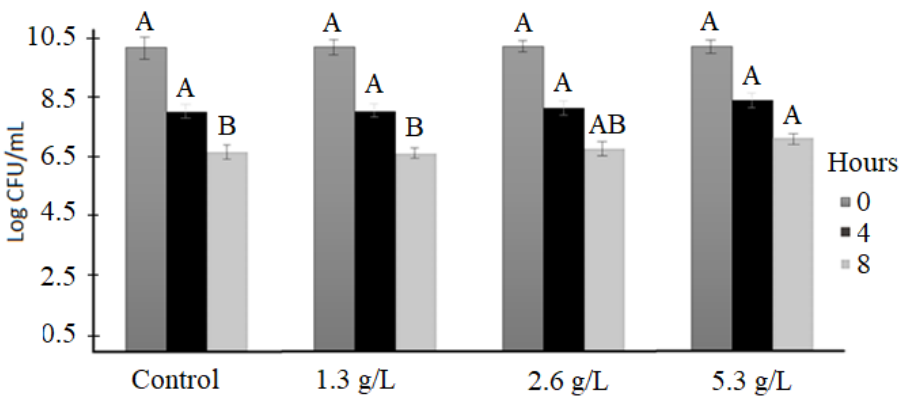
Figure 5. Log counts of S. thermophilus to show bile tolerance as influenced by carao concentration and incubation time over 8 h. AB Values not containing a common letter over various concentrations for a given time are significantly ( p < 0.05) different.